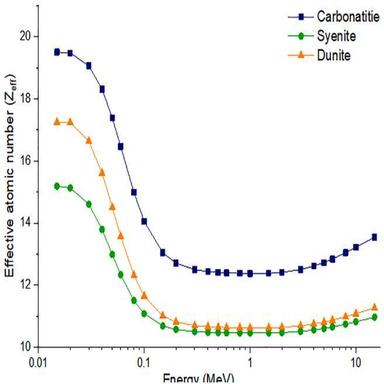
Variation of effective atomic number (Zeff) as a function of photon energy (MeV).